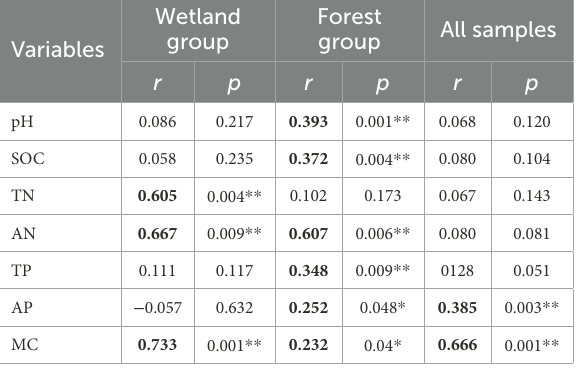
TABLE 4 Mantel test to determine the correlations between the environmental variables and acidobacterial community compositions at two habitats of wetland and